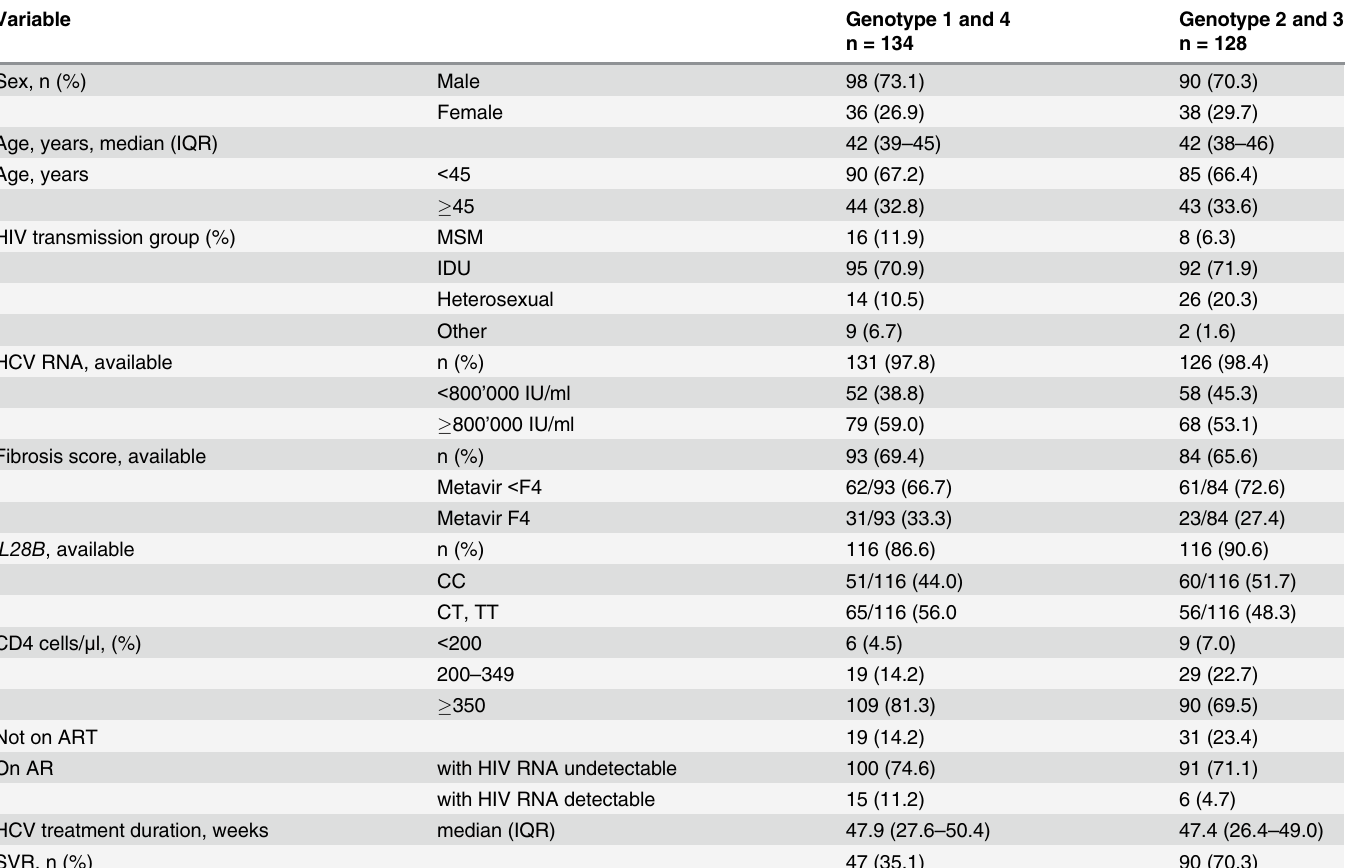
Table 1. Patient characteristics at hepatitis C virus (HCV) treatment start, treatment duration and sustained virologic response (SVR) according to HCV genotype